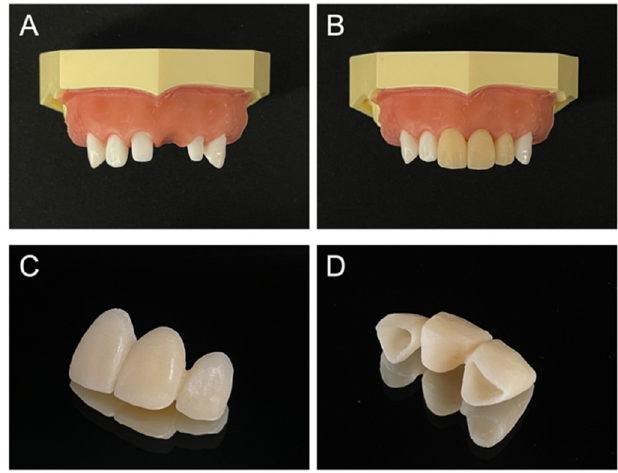
Figure 1. ( A ) Tooth preparation-formed model. ( B ) Provisional restoration attached. ( C , D ) Provi- sional restoration (ovate pontic).